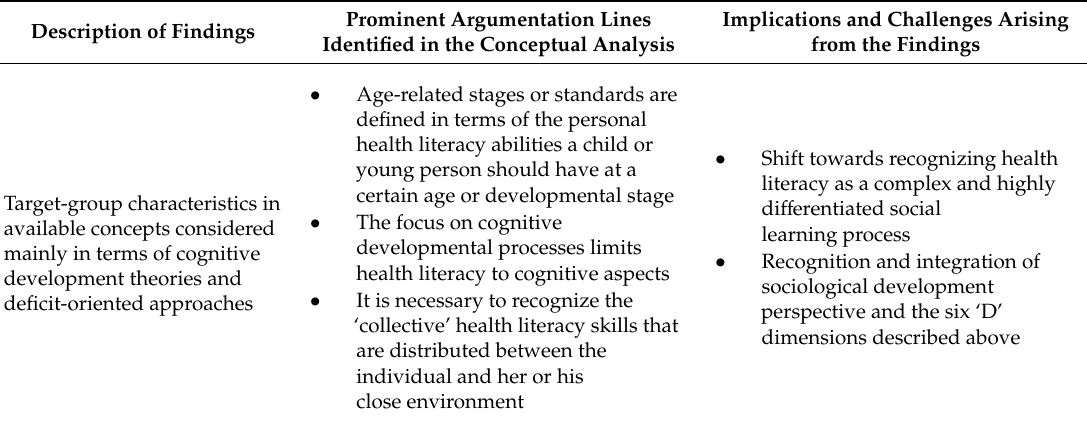
Table 7. Summary of conceptual reflections on health literacy and target-group